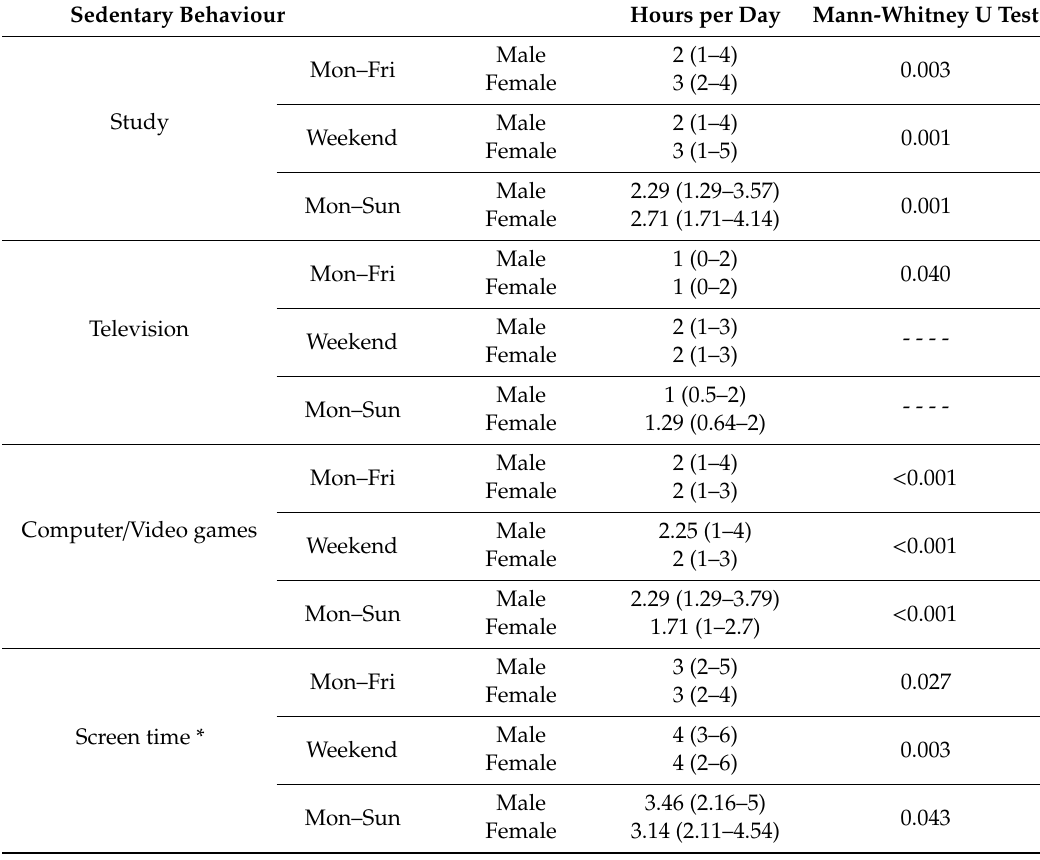
Table 4. Sedentary behaviour by gender. Variables expressed as median (interquartile